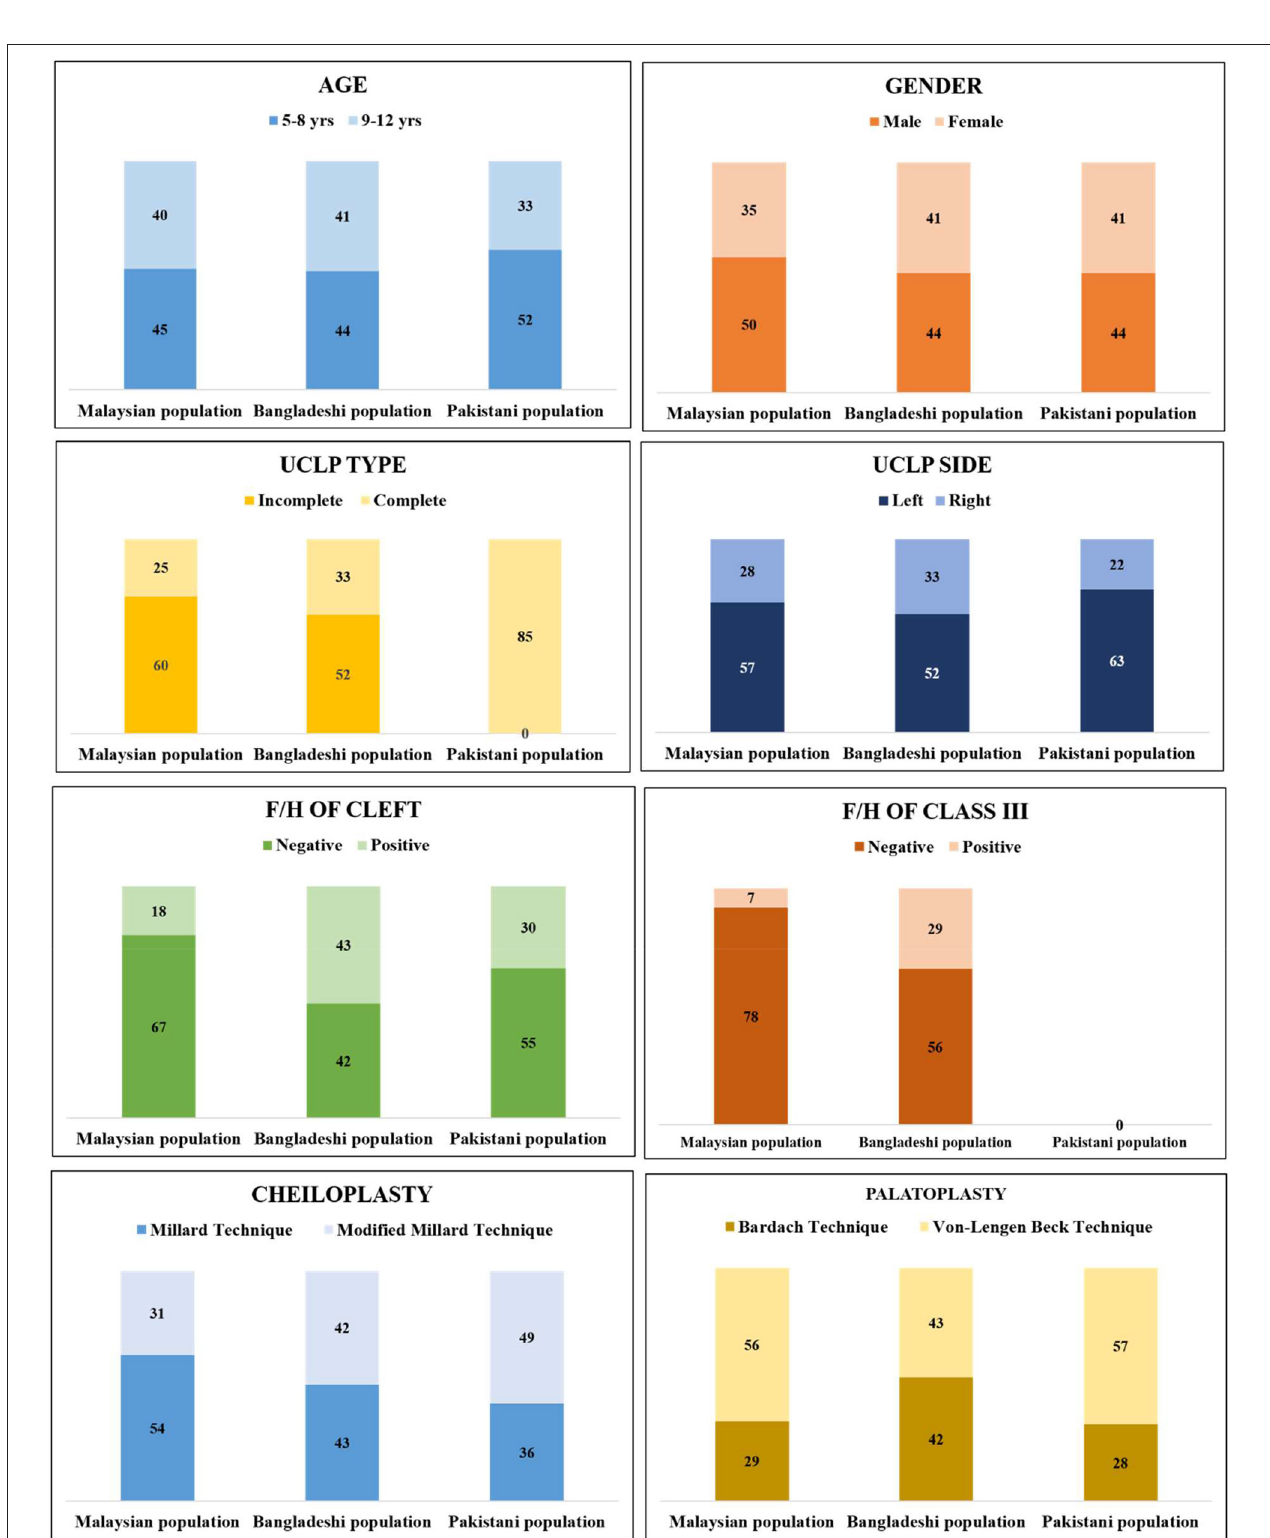
FIGURE 1 | Distribution of all subjects from three populations with multiple factors. (All the Pakistani UCLP subjects were complete type of UCLP. No record was found regarding family history of class III malocclusion in Pakistani UCLP subjects).